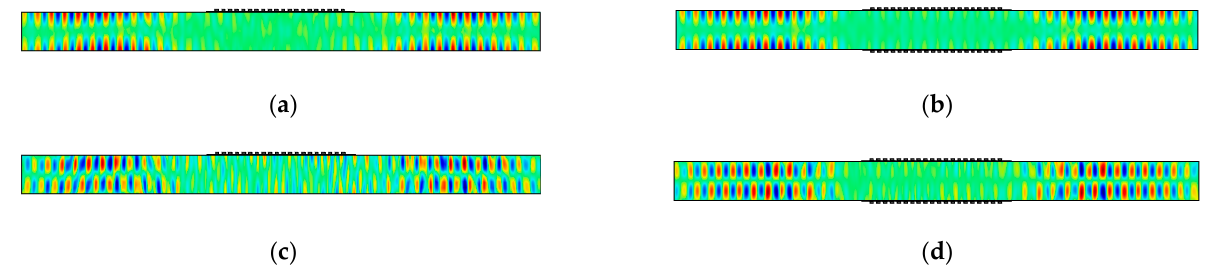
Figure 15. Snapshots at 40 μ s of S1 Lamb wave mode actuation with 602 kHz signal: ( a ) u 1 displacement from single-sided MST; ( b ) u 1 displacement from double-sided MST in-phase; ( c ) u 3 displacement from single-sided MST; ( d ) u 3 displacement from double-sided MST in-phase. The plots are stretched vertically for clarity.